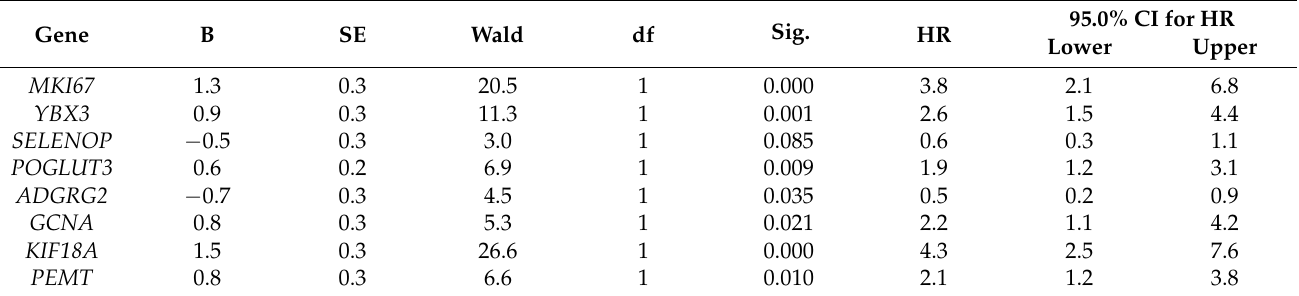
Cox regression, backward conditional. Table A4. Multivariate Cox regression overall survival analysis between MKI67 and the 10 high- lighted genes (Method